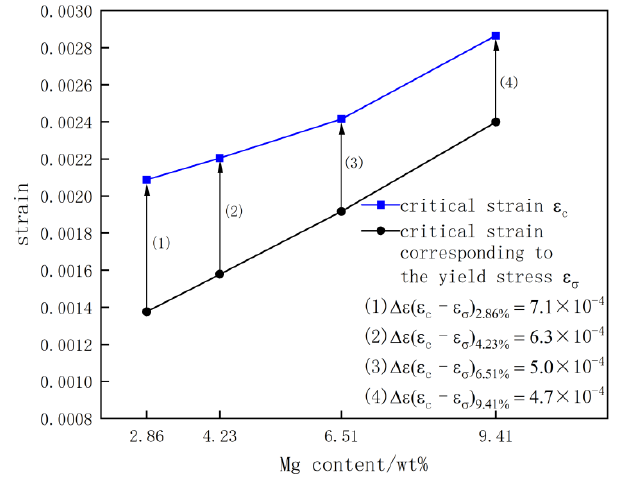
Figure 8. Curves of ε c , ε σ and ∆ ε of the quenched Al-(2.86~9.41) Mg alloy sheet with increasing Mg content.